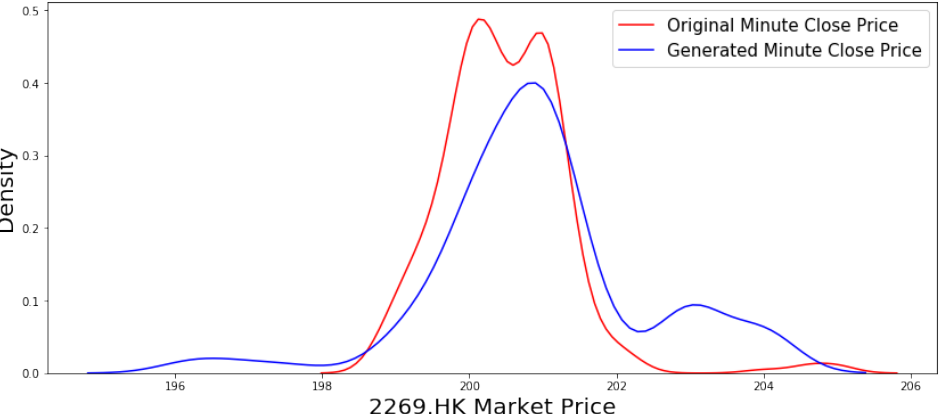
Figure 3. Generated real price at the minute interval (blue) and original market close prices (red) are plotted for 2269.HK. Starting from the first minute, the auction period will impact the following several trading minutes. The generated real prices are pretty close to the original input, as shown in tick movement.